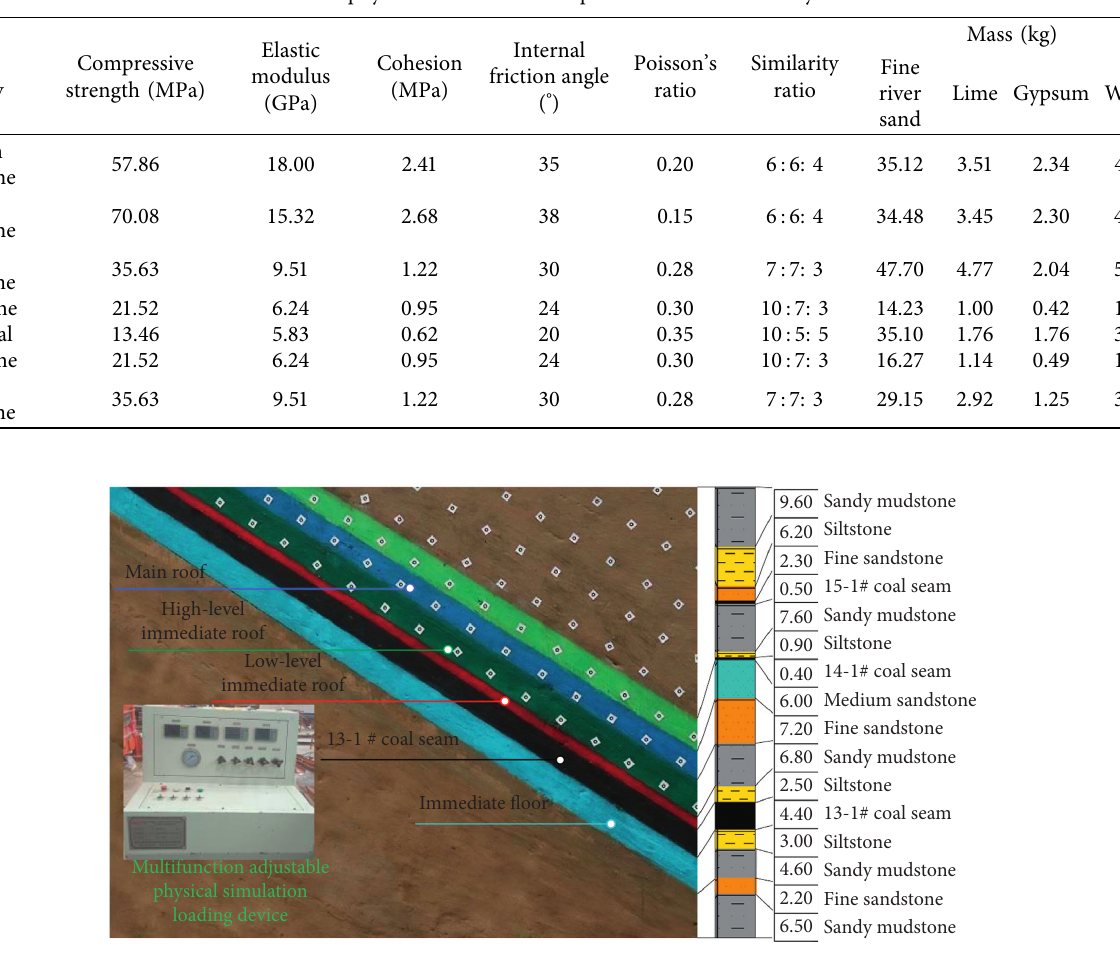
Figure 3: Physical analog model.